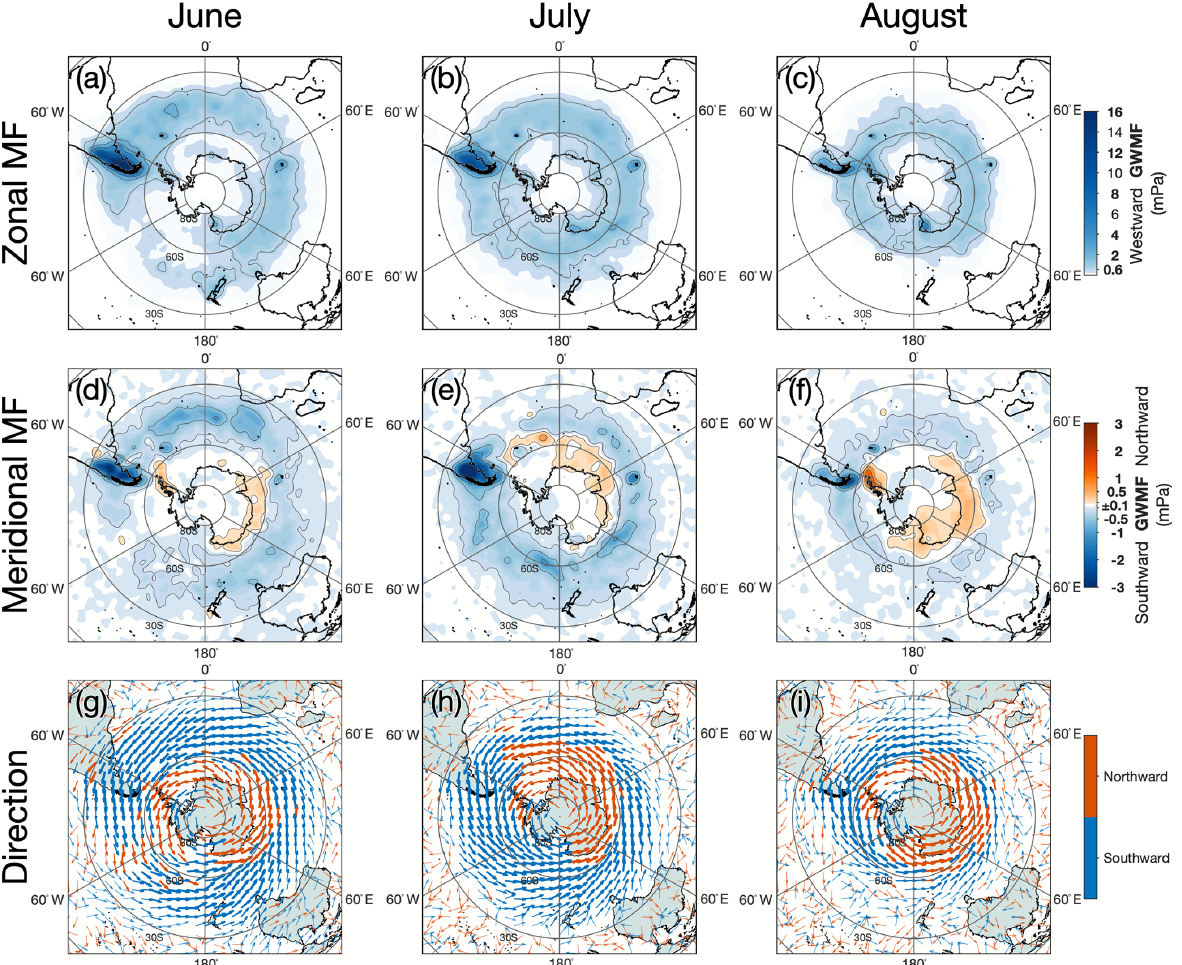
Figure 8. Monthly mean zonal (a, b, c) and meridional (d, e, f) gravity wave momentum flux at z = 40km during June, July and August 2010. Monthly mean northward (southward) horizontal wavevector directions (g, h, i) are shown by orange (blue) arrows. The thicknesses of the arrows in (g, h, i) are scaled for mean wave amplitude in the corresponding months from Fig. 7a–c.